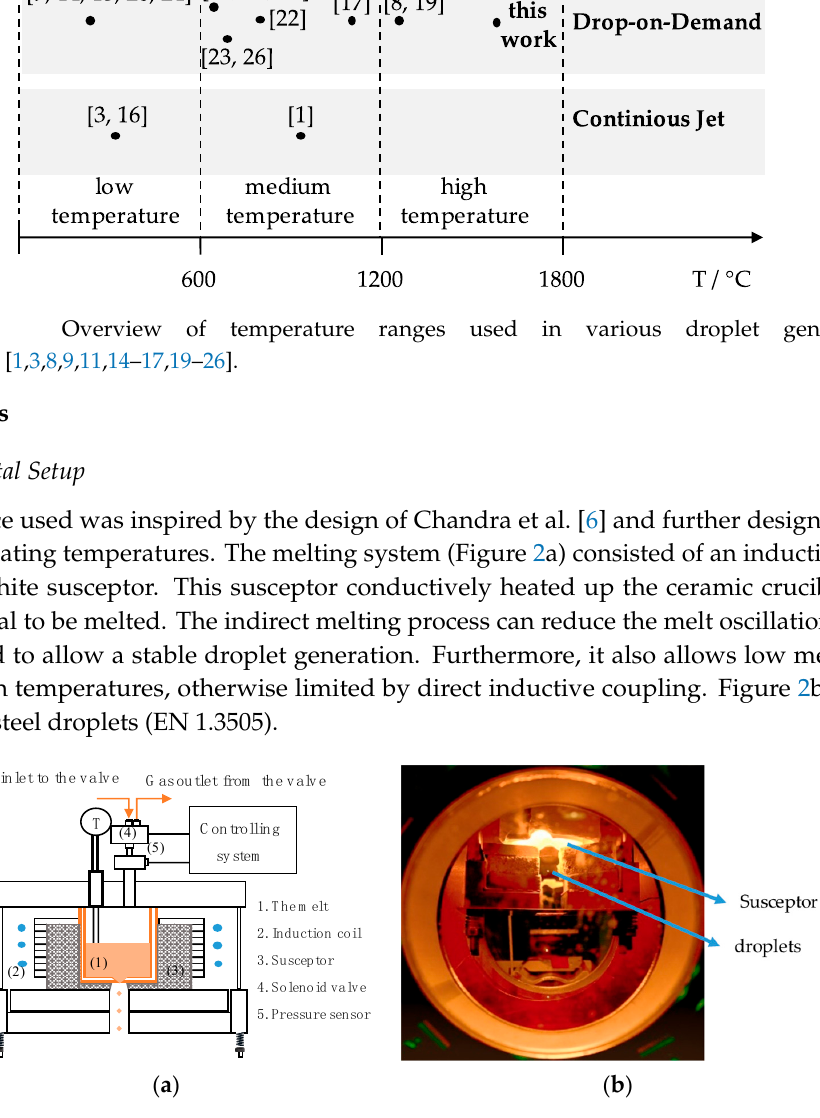
Figure 2. Experimental setup: ( a ) schematic view of the top plate of the droplet generator, ( b ) the view through the top window of the droplet generator during the experiment showing the glowing susceptor and the detached droplets during the process (Melt: EN 1.3505).